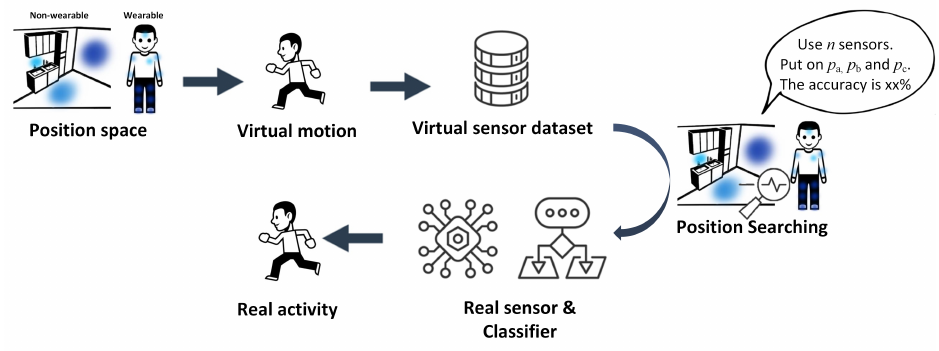
Figure 1. Overview pipeline of sensor position optimization with virtual sensor data.